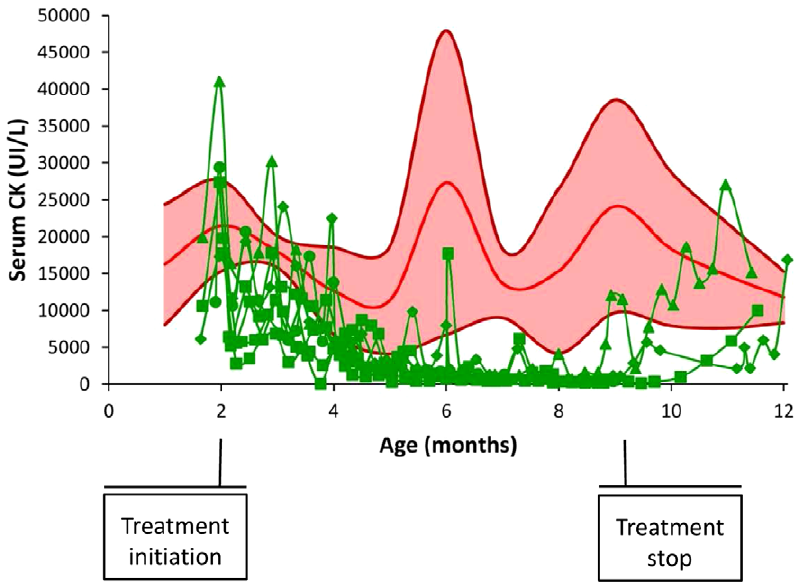
Figure 1. Evolution of the serum CK activity in the treated dogs. This graph represents the evolution of the serum CK in the treated dogs (green curves) in function of the age, before, during and after treatment in comparison with the mean value (red curve), 6 SD (pink area) of 14 untreated GRMD dogs. The drop in the CK values during treatment and the re-increase after the treatment stop are remarkable.